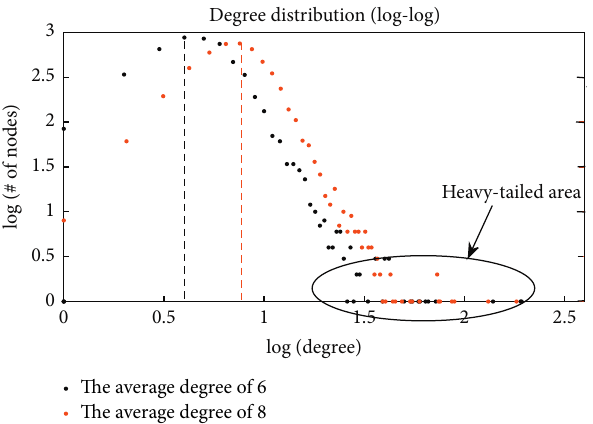
Figure 5: An example of the distribution of network